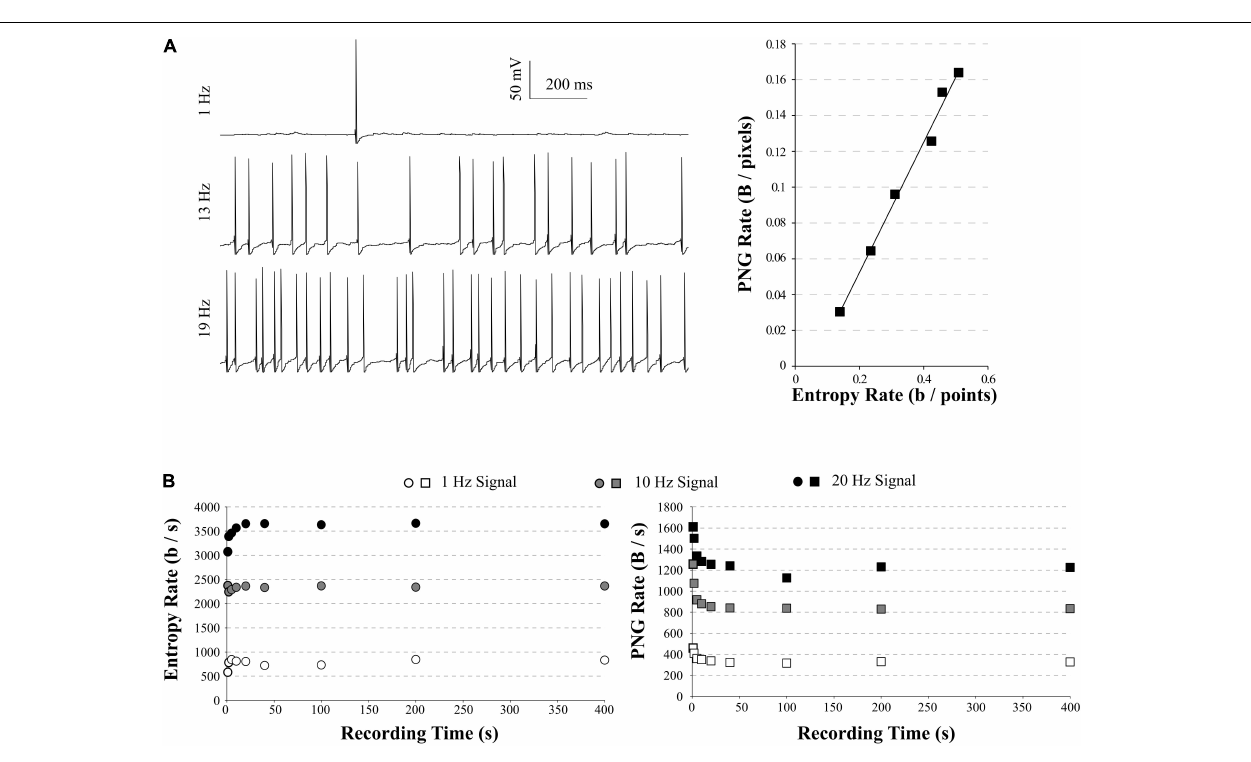
EPSP size produced by this synapse was called wSyn_supp. When wSyn_supp was weak, this synapse did not drive the spiking of the model ( Figure 4C , up left ). When wSyn_supp was strong, this synapse drove the spiking of the model ( Figure 4C , down left